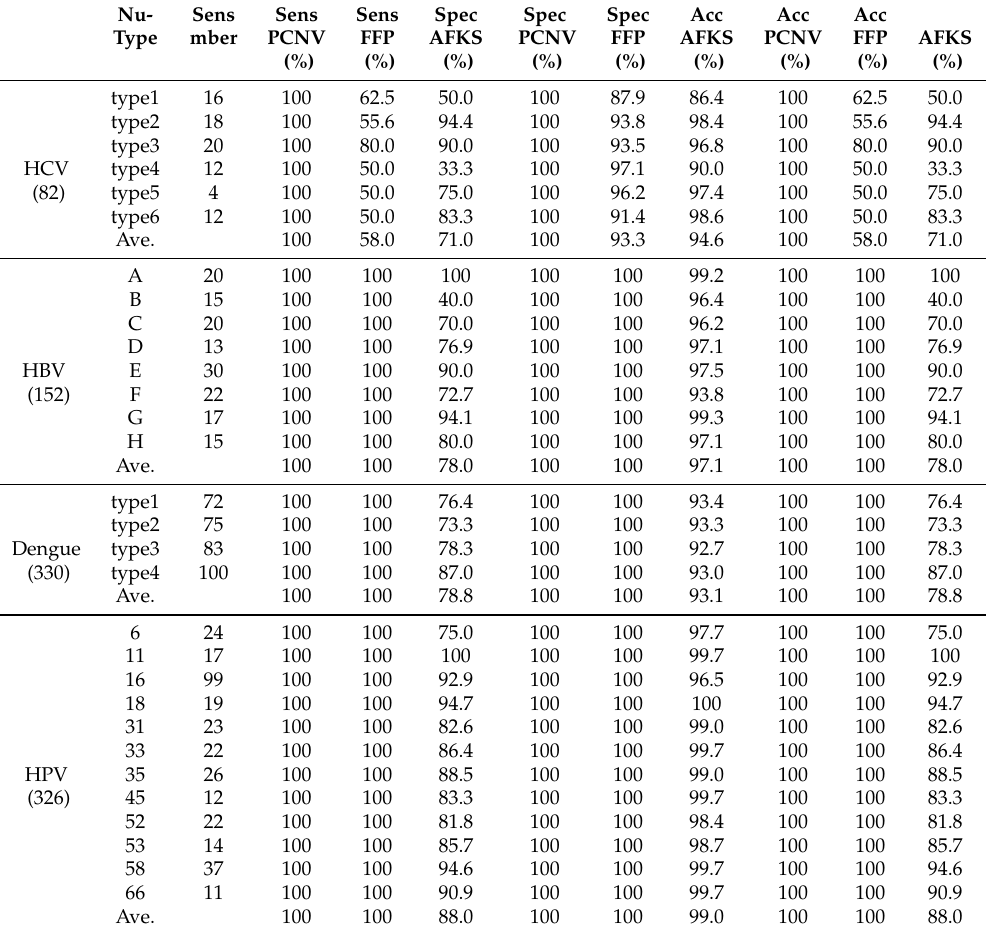
Table 2. Sensitivity (Sens), Specificity (Spec), and Accuracy (Acc) measures of classification are reported for the four virus datasets. For each dataset, the Ave. line displays average values for each